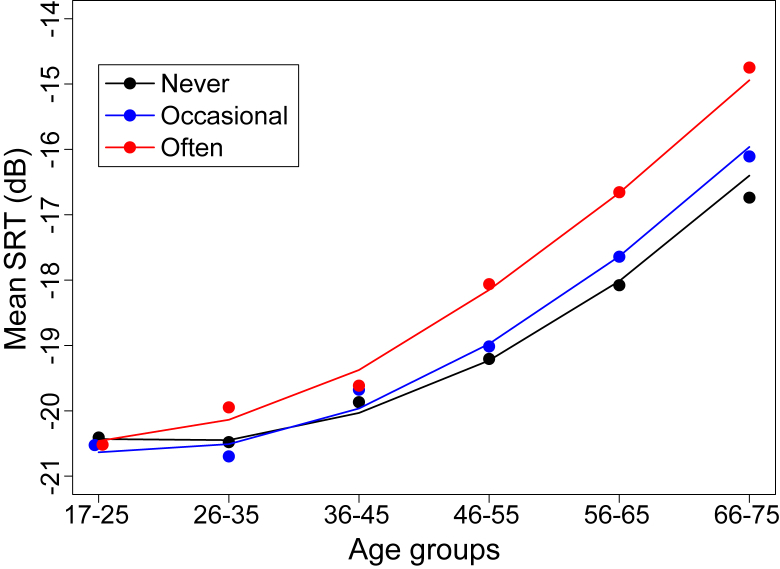
Relation between speech reception threshold (SRT) and tinnitus with age. Coloured points show mean data and lines show model predictions (SRT ∼ Age + Ageˆ2 + Tinnitus*Age).